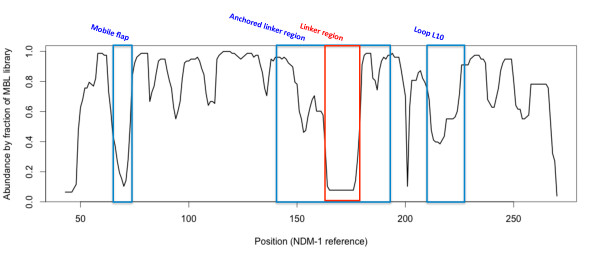
Structural abundances of NDM-1 based on MBL structural fragment comparisons. (A) Structural abundance, per residue for NDM-1. The first major decrease in abundance at approximately residue 68 corresponds to the mobile flap found in B1 MBLs. The region of structural disagreement starting at about residue 50 and continuing for 30 residues corresponds to the linker region. The last decrease in abundance, at about residues 210-225 align with a lengthy loop region in other MBLs. The flap, anchored linker region and loop L10 are demarcated using the ranges specified in Figure 2.